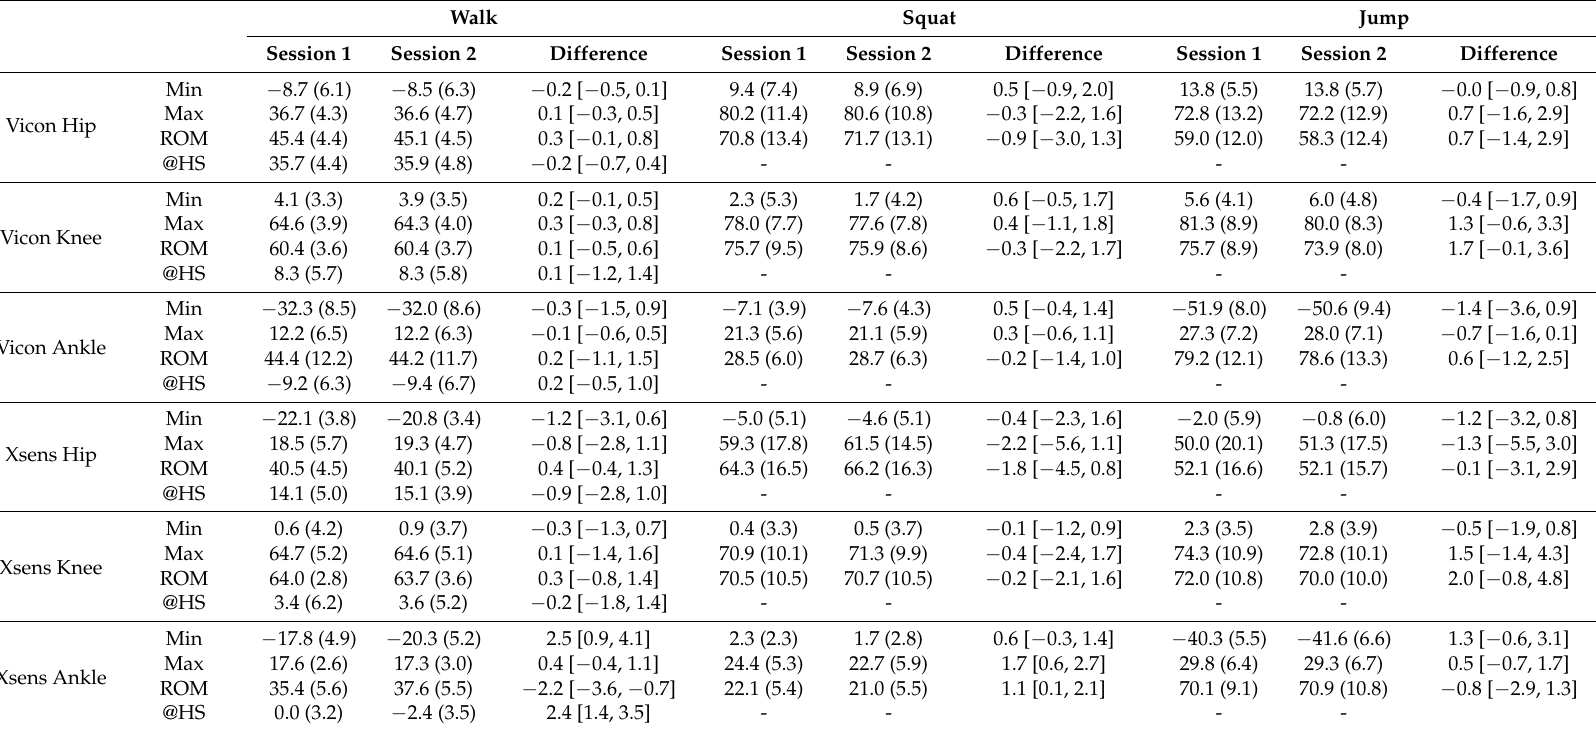
Data for each session are mean (standard deviation). Data for the difference are difference [95% confidence